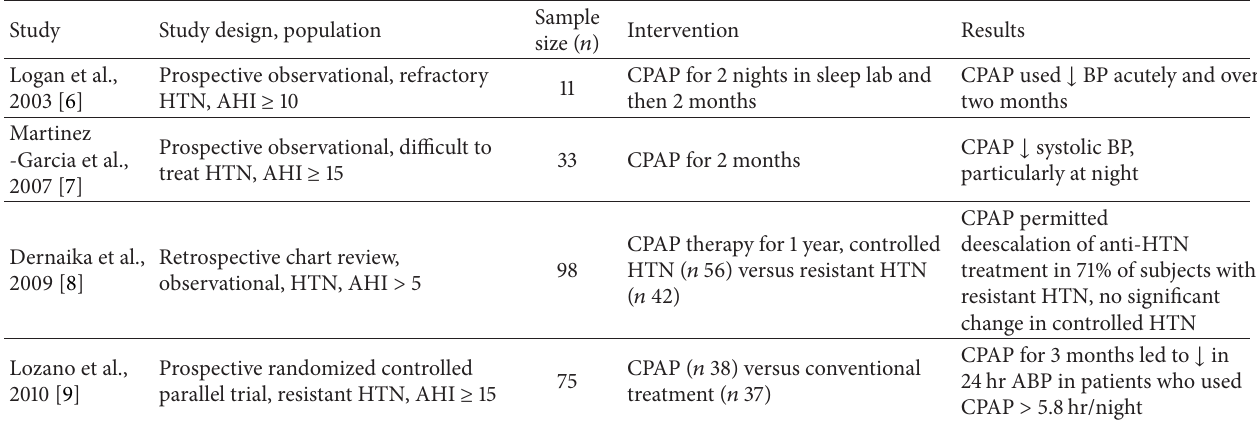
Table 1: Effects of continuous positive airway pressure therapy on resistant